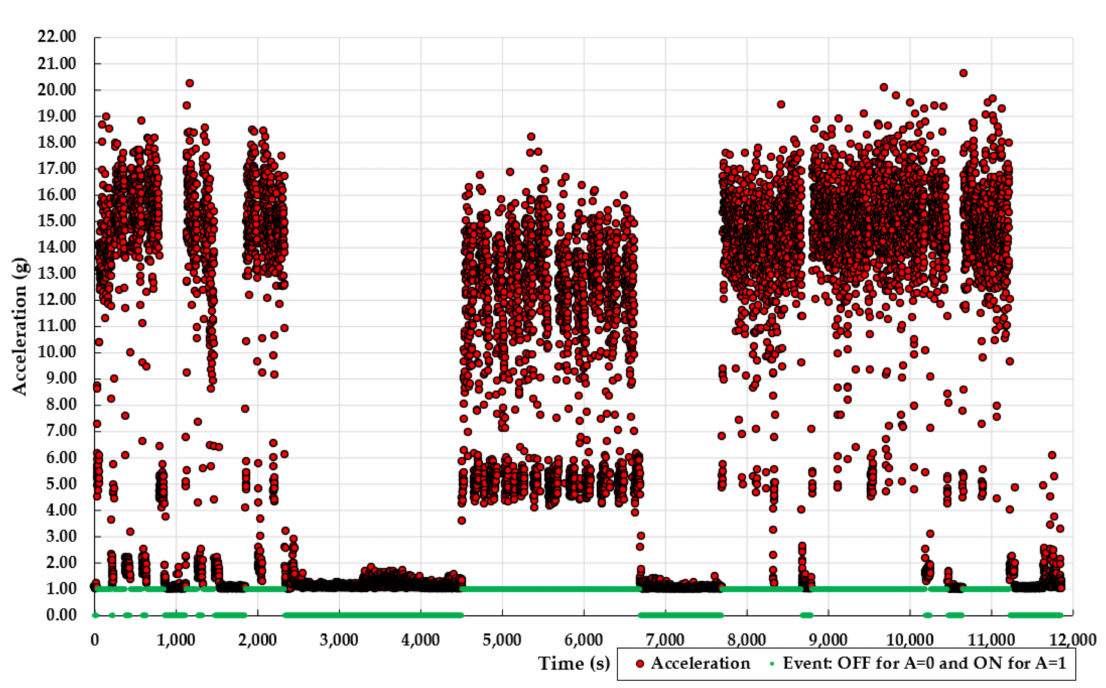
Figure A4. Description of datasets used in the testing phase of the MLPs: TEST_E2. Note: conventionally, a value set at 0 (A = 0) indicates the events documented as OFF, while a value set at 1 (A = 1) indicates the events documented as ON.